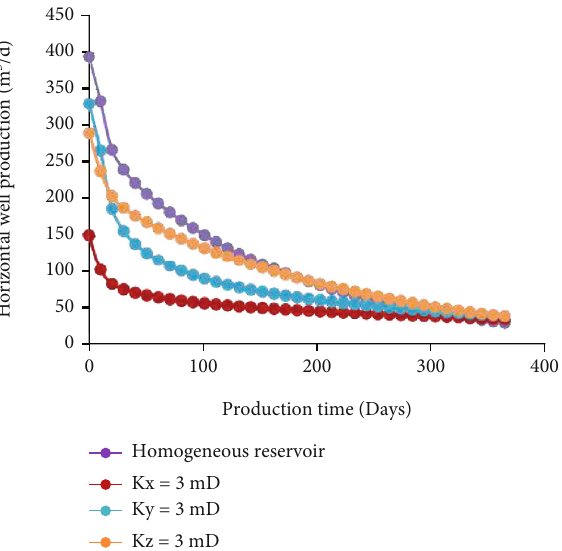
Figure 9: Daily variation curve for horizontal wells.